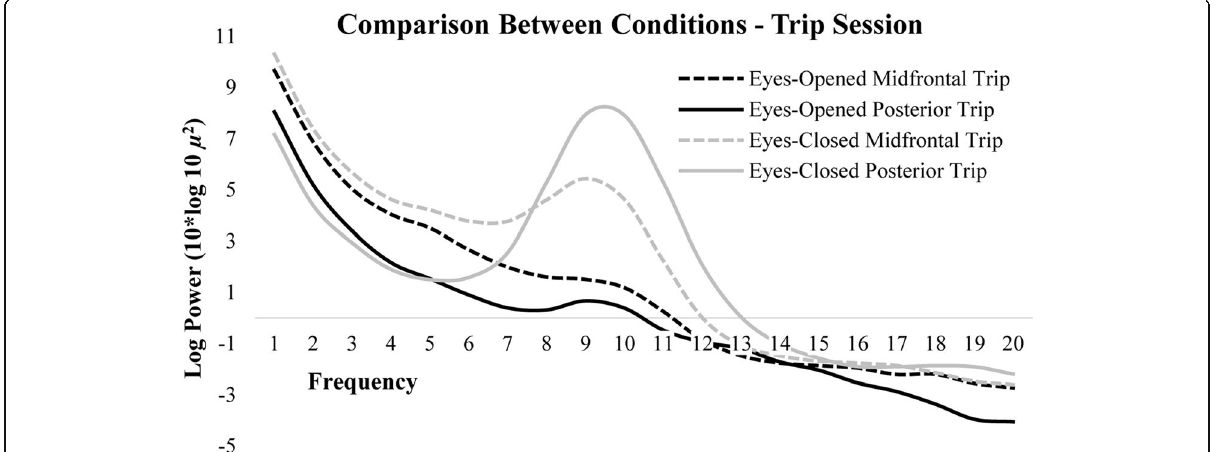
Fig. 7 Log transformed spectra for the trip session averaged across midline and posterior electrodes during the eyes-opened and eyes-closed